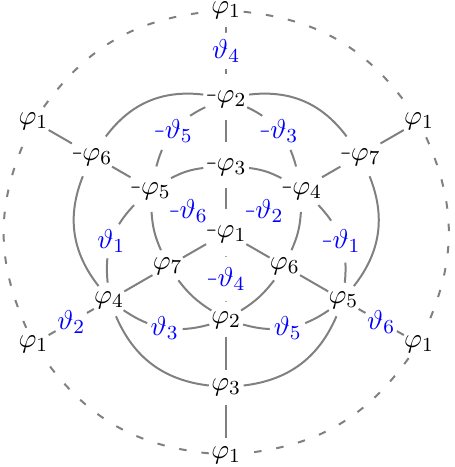
Fig. 12. Topology of the refinement of hemisphere intersections ( ϕ k ) induced by the 11 neighbours ( ϑ k in blue) of the central cell. − ϑ k or − ϕ k denote ϑ k or ϕ k reflected in the origin, respectively. It has been projected from ϕ 1 onto the plane θ = π / 2 , and rotated counterclockwise by π / 2 to emphasise the